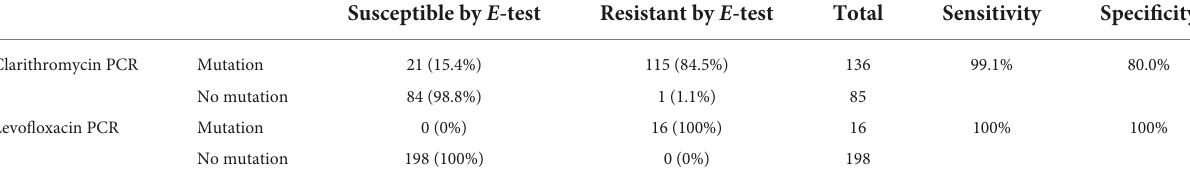
TABLE 2 Presence or absence of PCR mutations for clarithromycin and levofloxacin versus sensitivity or resistance results by E -test (gold